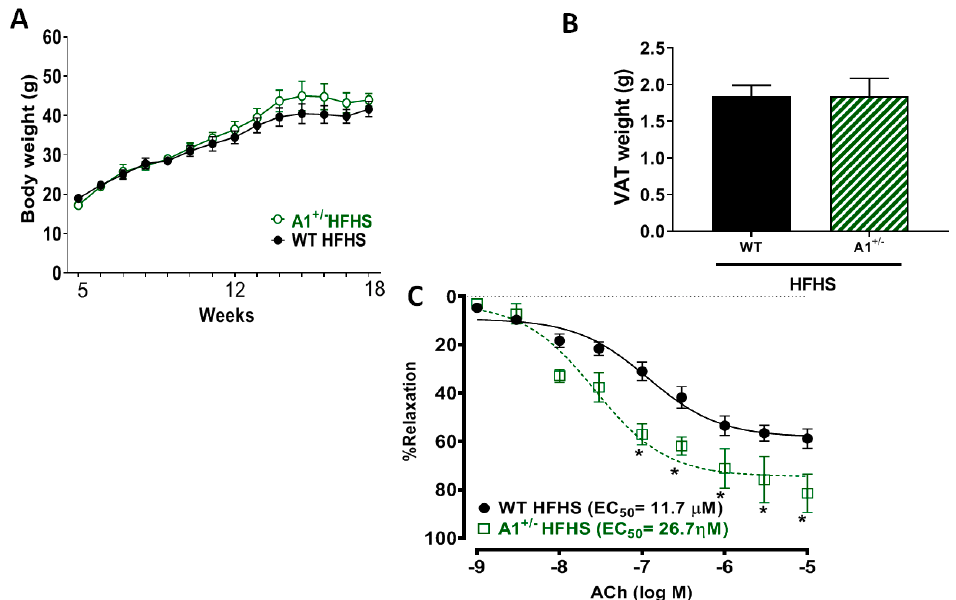
Figure 8. A1 deletion enhanced endothelium-dependent vasorelaxation with no effect on the gain of body and VAT weight. Effect of WT and A1 heterozygous deleted (A1 +/ − ) mice challenged with HFHS diet on gain in body weight ( A ), VAT weights ( B ), and endothelium-dependent vasorelaxation to acetylcholine (ACh) ( C ). EC 50 : half maximal effective concentration for the ACh. Values are mean ± SEM, n = 4–6 mice/group. * P < 0.05 when compared to WT HFHS. Int. J. Mol. Sci. 2019 , 20 , x FOR PEER REVIEW 272 2.9. Arginase Inhibition Prevented Vascular Endothelial Dysfunction Induced by Conditioned Medium (CM) 273